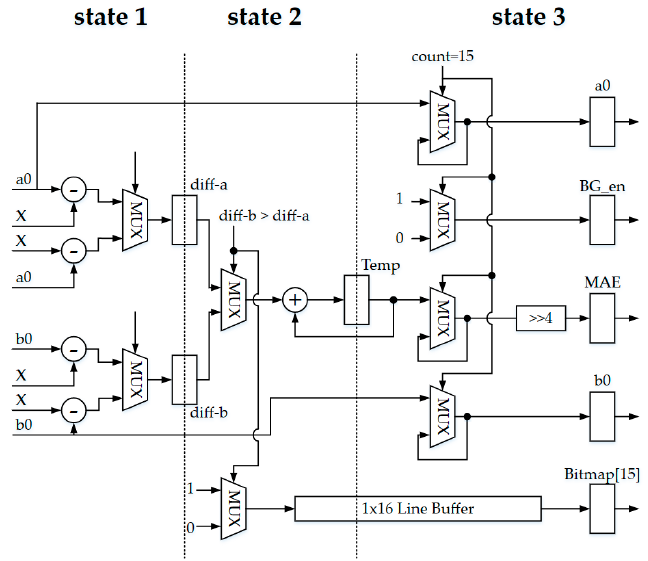
Figure 9. The architecture of the BTC training module. State 1 is calculating the different between current value, a0, and b0. State 2 is comparing the different from State 1. State 3 is calculating the MAE value and deciding the best reconstruction value and bitmap.